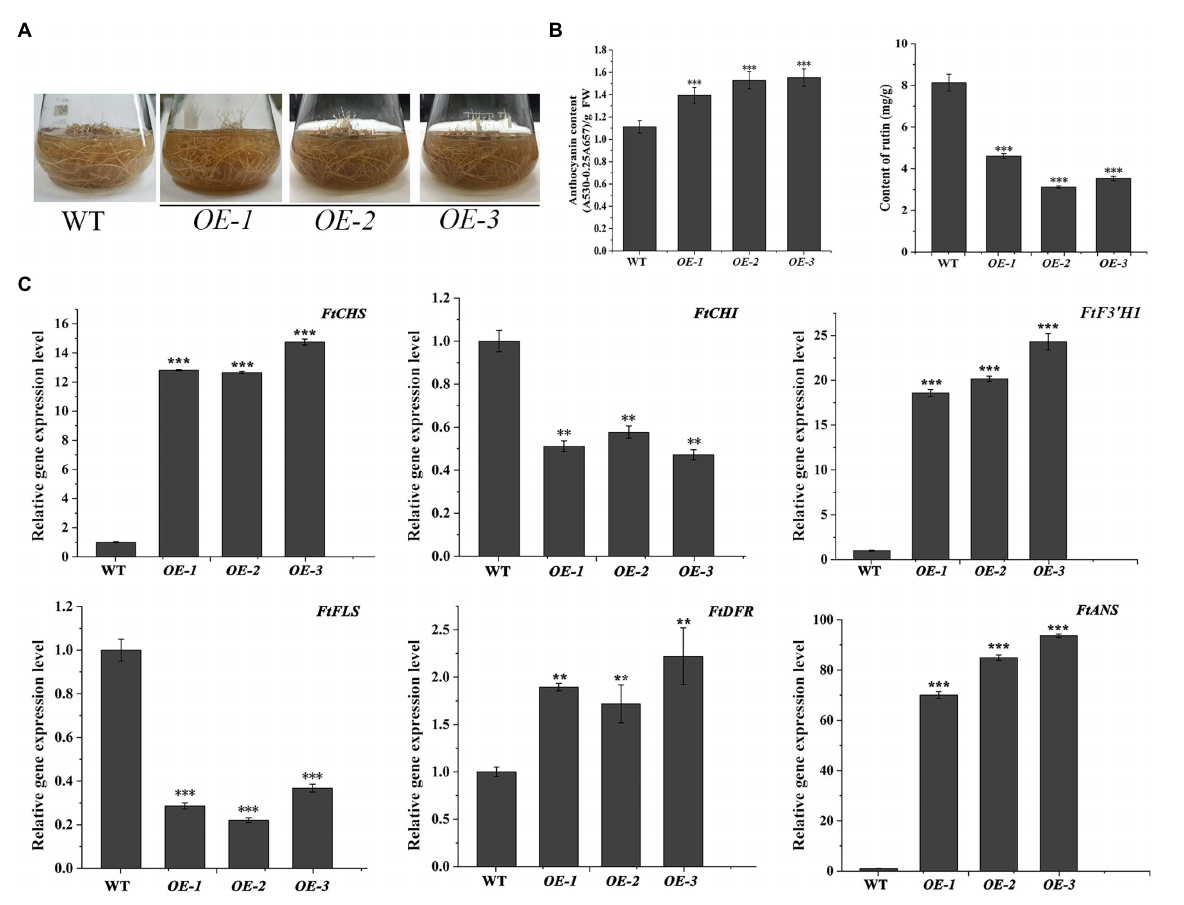
FIGURE 7 Overexpression of FtF3 ′ H1 in TB hairy roots. (A) Phenotypic comparison between WT and transgenetic TB hairy roots overproducing FtF3 ′ H1 (OE- 1, OE-2 and OE-3). (B) Determination of anthocyanin and rutin contents in hairy roots. The average value is calculated repeatedly by three times of technology. Error bars represent ± SD. ** p < 0.01 and *** p < 0.001. (C) Expression analysis of genes associated with the anthocyanin biosynthesis in TB hairy roots by qPCR. FtH3 gene is the reference gene. The average value is calculated repeatedly by three times of technology. Error bars indicate ± SD. * p < 0.05, ** p < 0.01 and *** p <